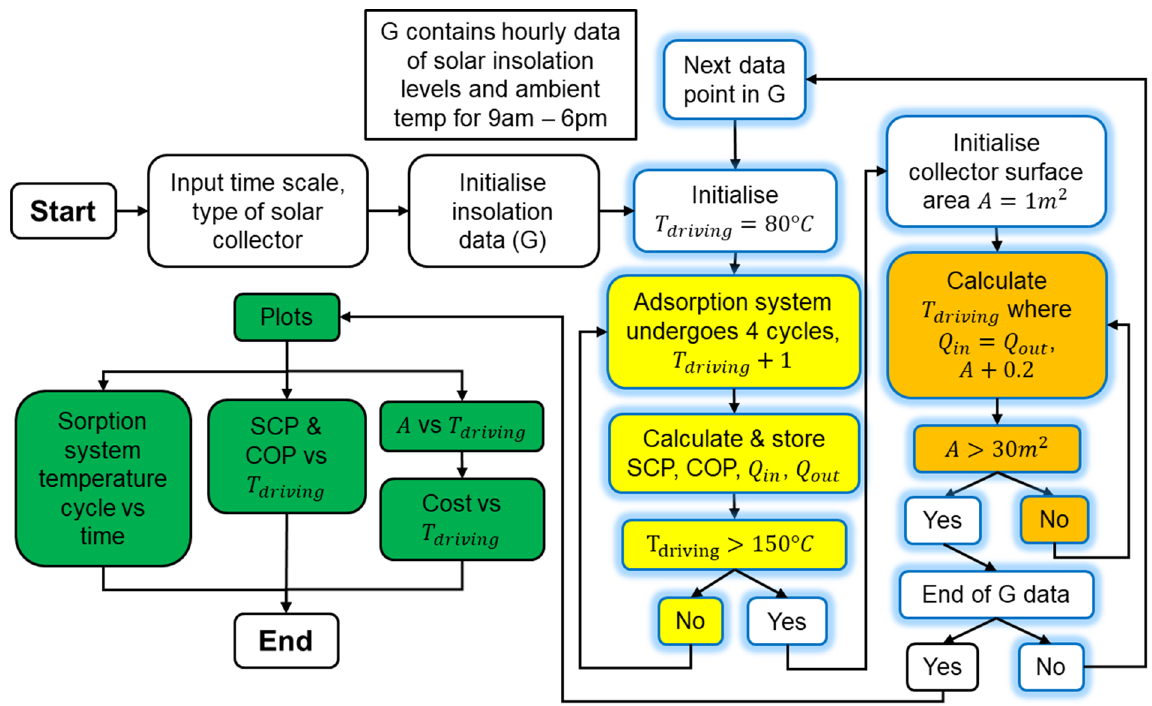
Figure 4. Solar ‐ driven adsorption air conditioning model algorithm flowchart [10]. Figure 4. Solar-driven adsorption air conditioning model algorithm flowchart [10].